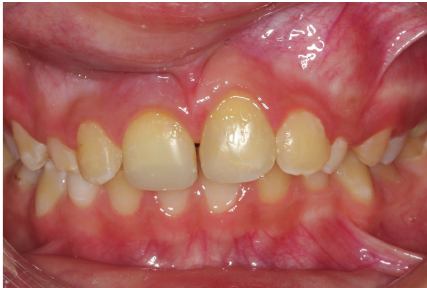
Figure 4: Frontal view, 18 months after trauma, slight infraposition of avulsed